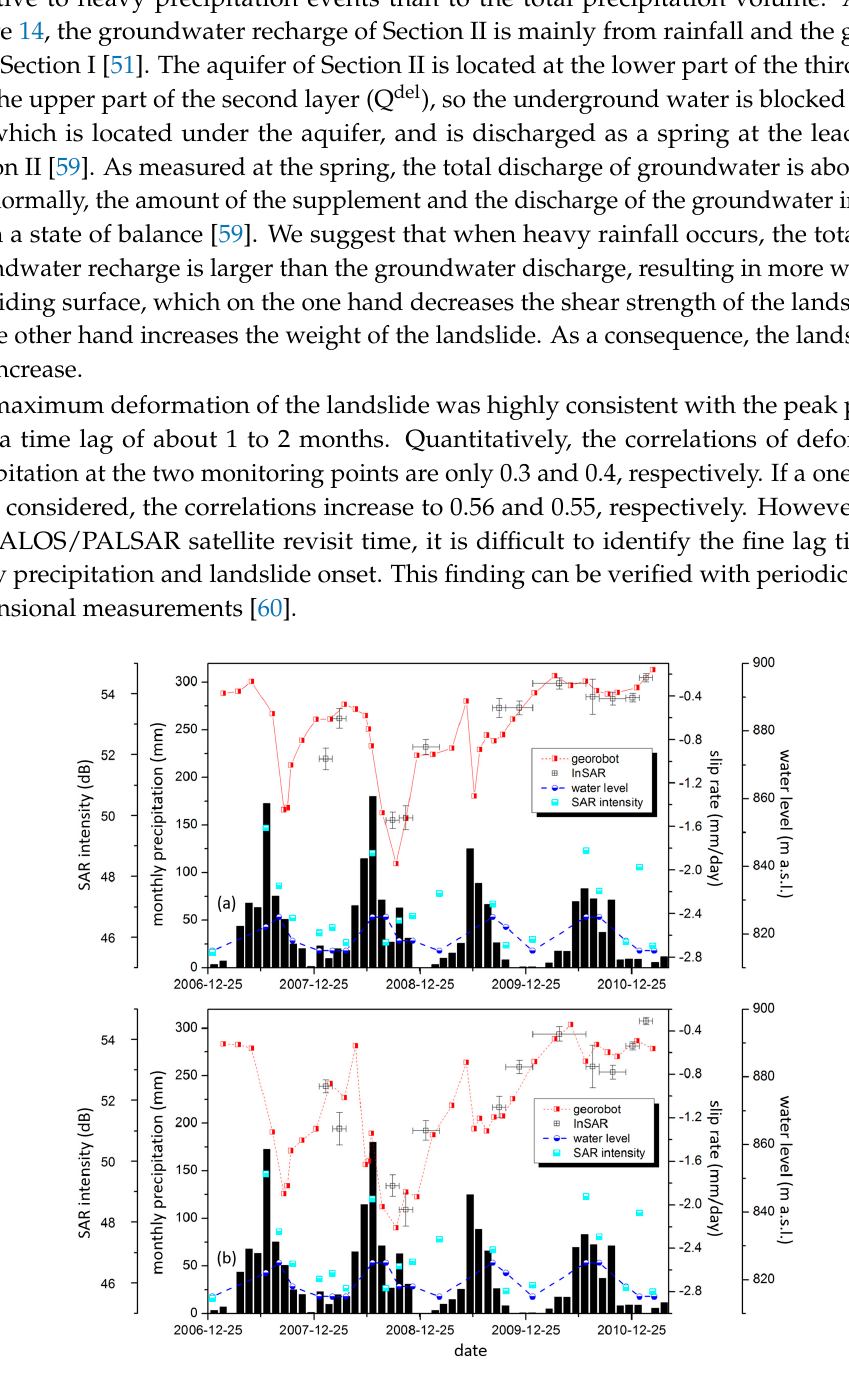
Figure 13. The correlation among Jinsha River water level variations, monthly precipitation and daily deformation rate acquired by InSAR and georobot for the monitoring points ( a ) TP08 and ( b ) TP04, where error bars of the InSAR monitoring on the Y-axis represent the uncertainty of the slip rate in the selected regions, and horizontal bars of the InSAR monitoring on the X-axis represent the time interval between the adjacent SAR acquisition dates. (Monthly precipitation data are cited from reference [59]).